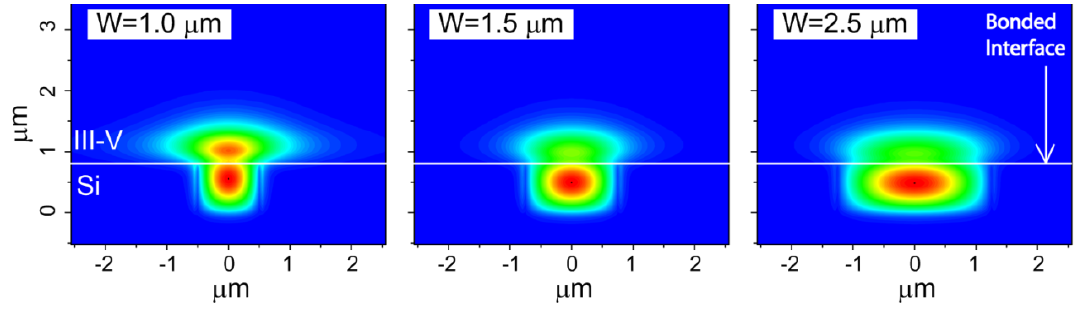
Figure 11. Mode profiles with different waveguide widths. The height of the Si waveguide is fixed at 0.7 μ m